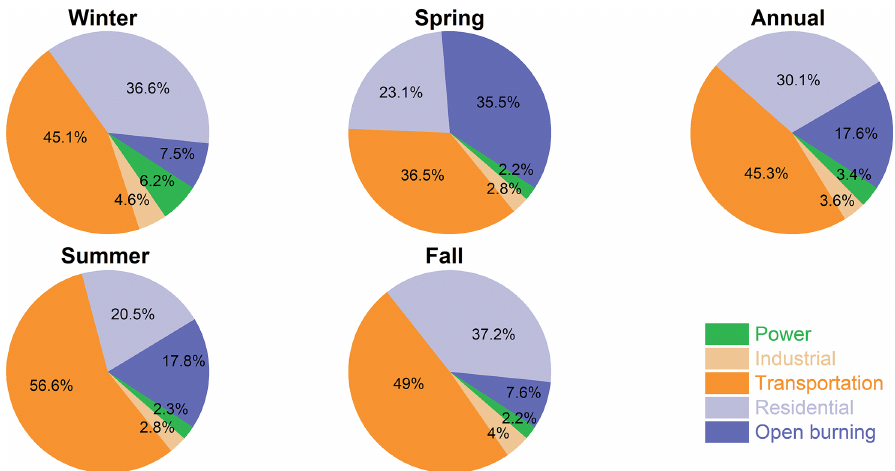
Figure 10. Source contributions to BC of five source sectors in each period based on the source-oriented model.